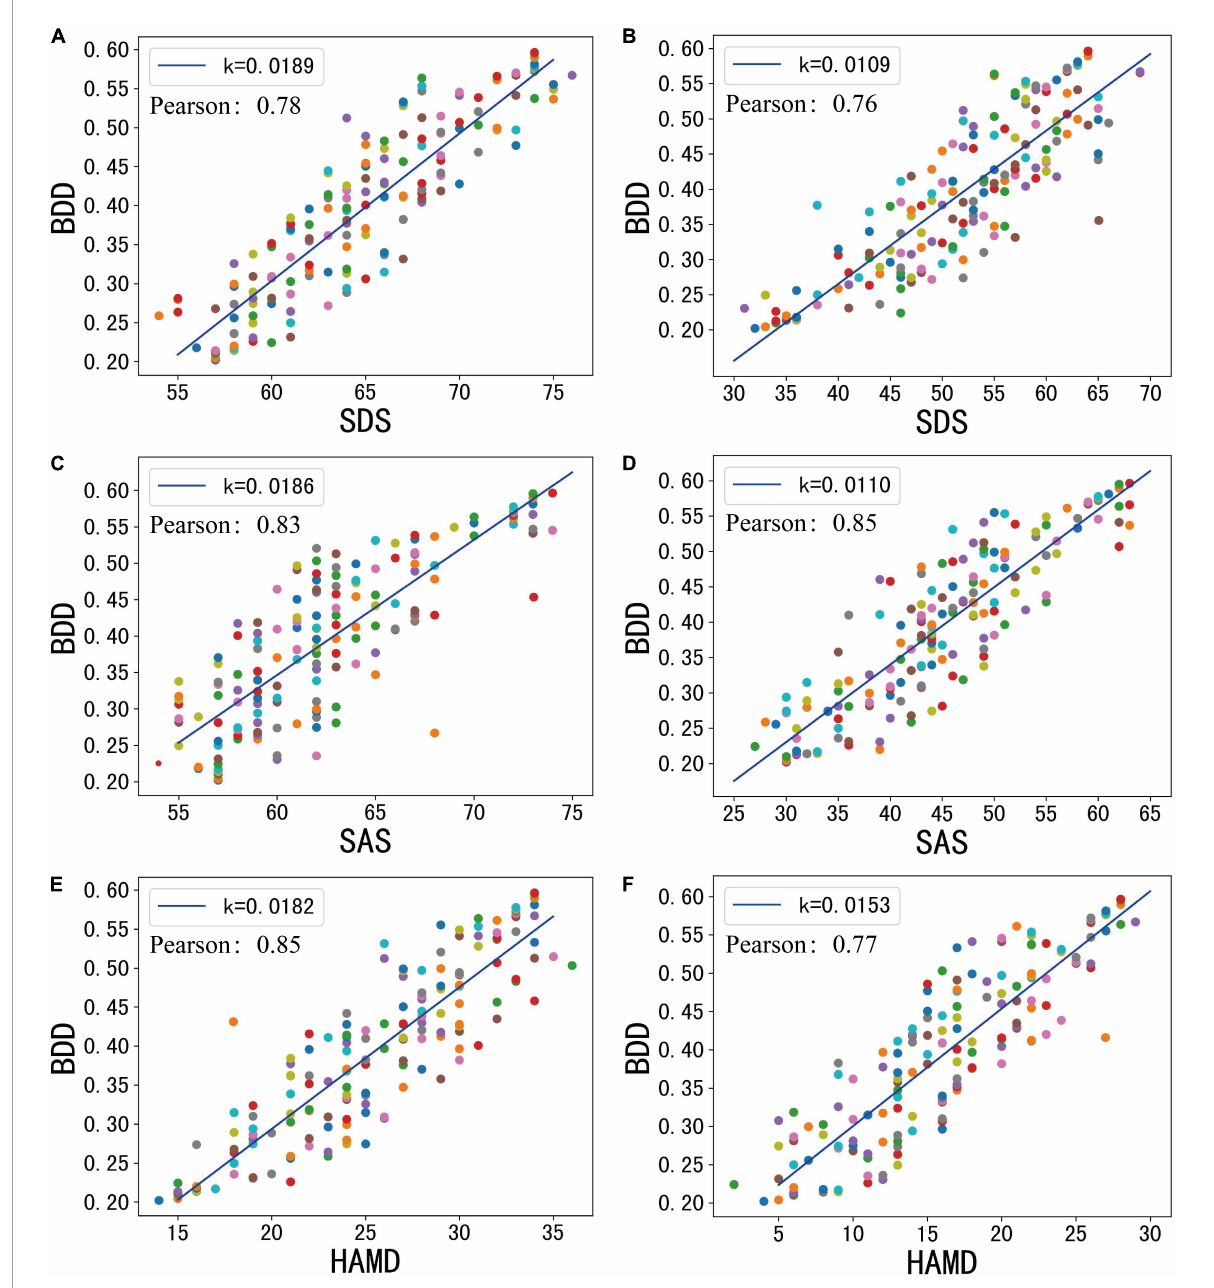
FIGURE6 The total score of mental statistics scale and model test results before and after psychotherapy. (A) Baseline SDS. (B) End SDS. (C) Baseline SAS. (D) End SAS. (E) Baseline HAMD. (F) End HAMD.